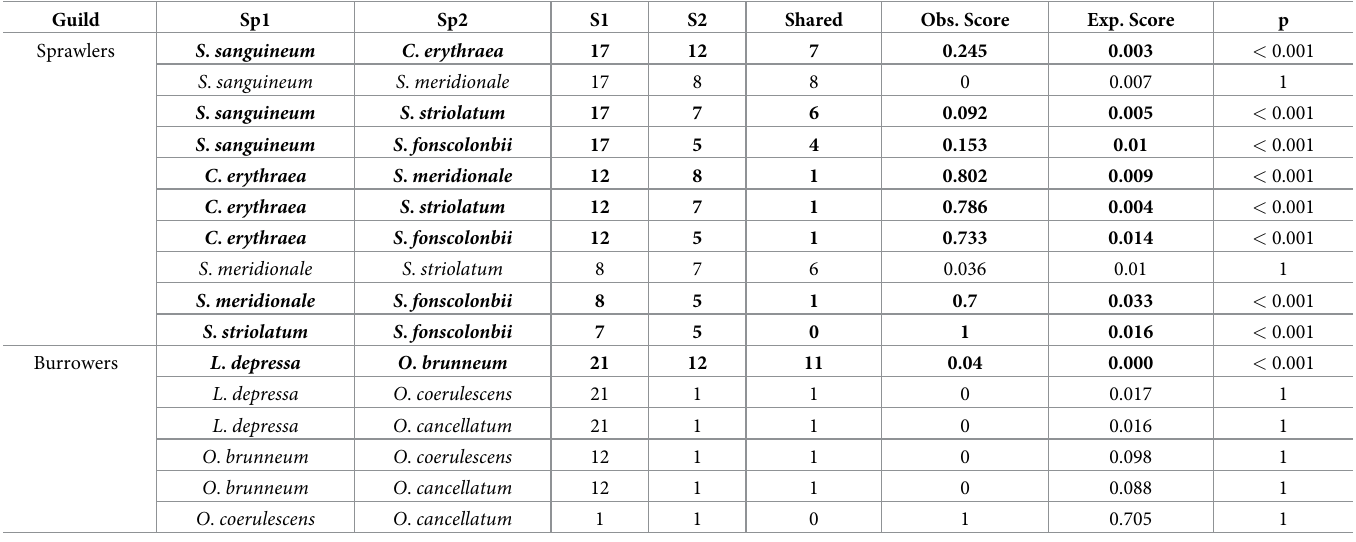
Table 4. C-score pairs analysis among the spralwers and burrowers guild species performed using abundance data. Sp: Species. S1 and S2: sites occupied respectively from species 1 and 2. Shared: number of shared sites. Obs. Score: Calculated C-score for the species pair. Exp. Score: Simulated C-score. In bold the significant species